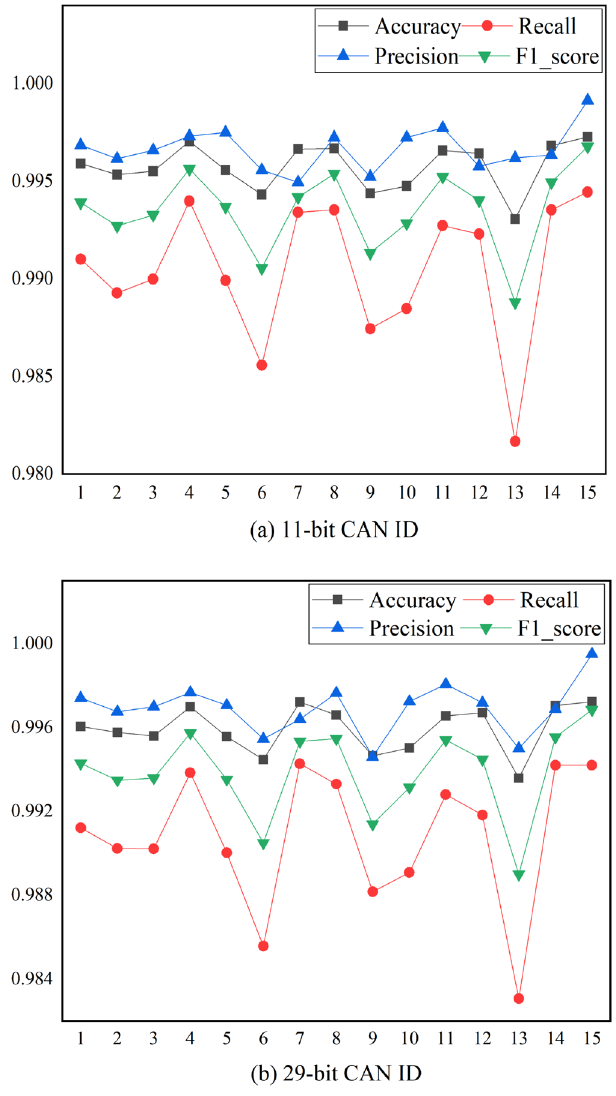
Figure 13. Test results of Mosaic coding methods under different invasion